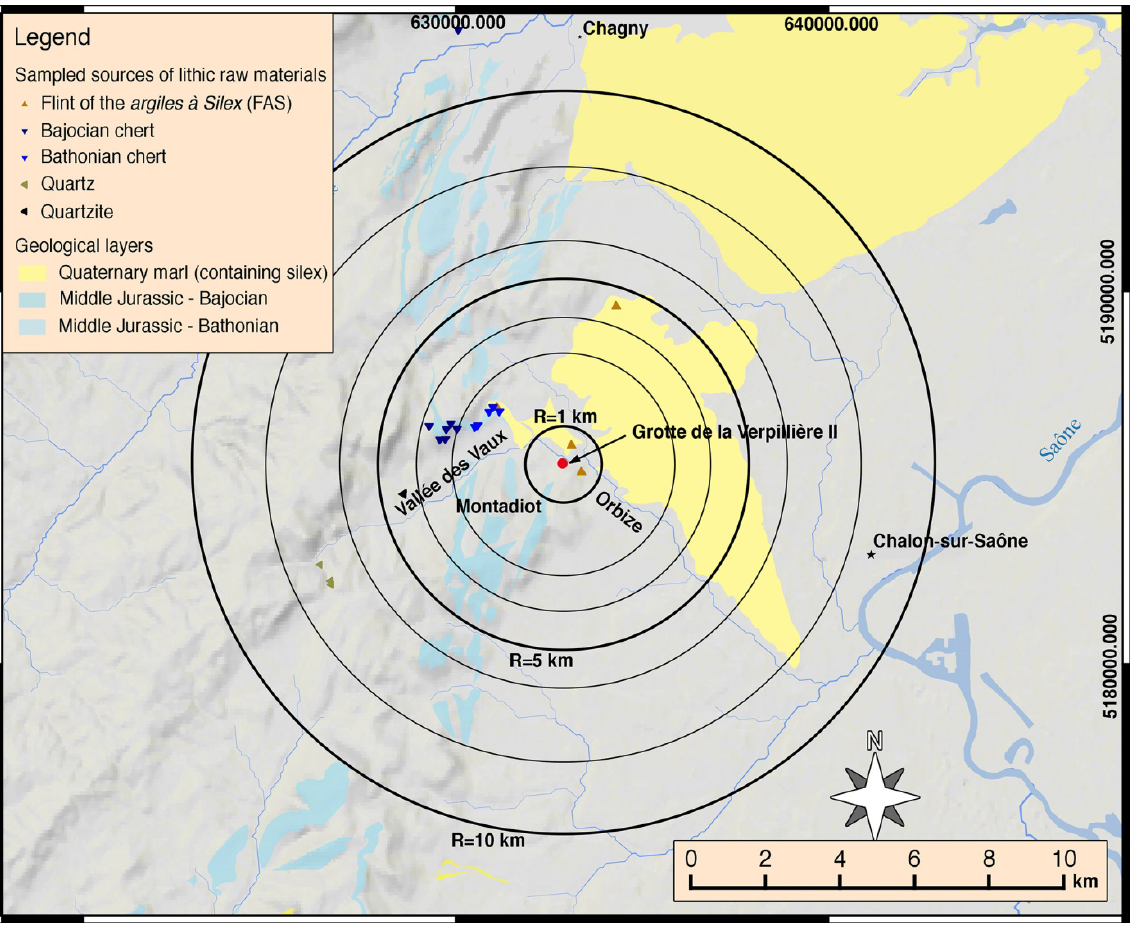
Figure 7. Distribution of sediments containing Jurassic chert (blue) and Flint from the argiles à silex (yellow) in the Côte chalonnaise (wider area of Chalon-sur-Saône). Map provided by M. Siegeris, base map from NASA Shuttle Radar Topography Mission 2000 (Jarvis et al . 2008) and raw material distribution by M. Siegeris.